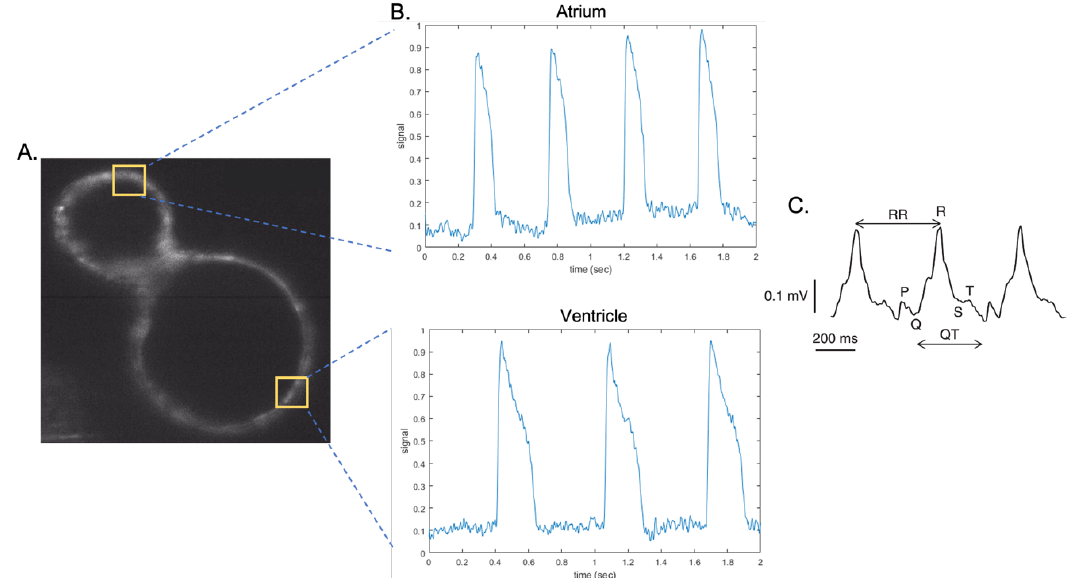
Figure 2. Optical mapping and ECG of the zebrafish heart. ( A ). Section of the heart of a 3 dpf zebrafish embryo expressing the Ace2n-mNeonGreen voltage sensor. The yellow squares indicate the areas in which fluorescence intensity is analysed to obtain the sample traces in ( B ). ( B ). Action potentials from a 3 dpf zebrafish embryo obtained with light sheet microscope. Top: atrial sample trace. Bottom: ventricular sample trace. ( C ). A raw ECG recording of a 2 dpf zebrafish embryo; P, Q, R, S, T waves, and RR and QT intervals indicated. (Figure modified from Thorsen et al. [69] ).